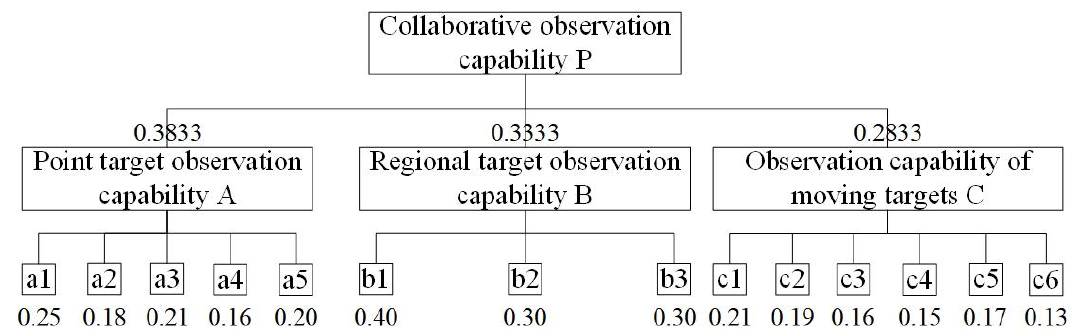
Figure 2. Weight allocation of evaluation indicators.